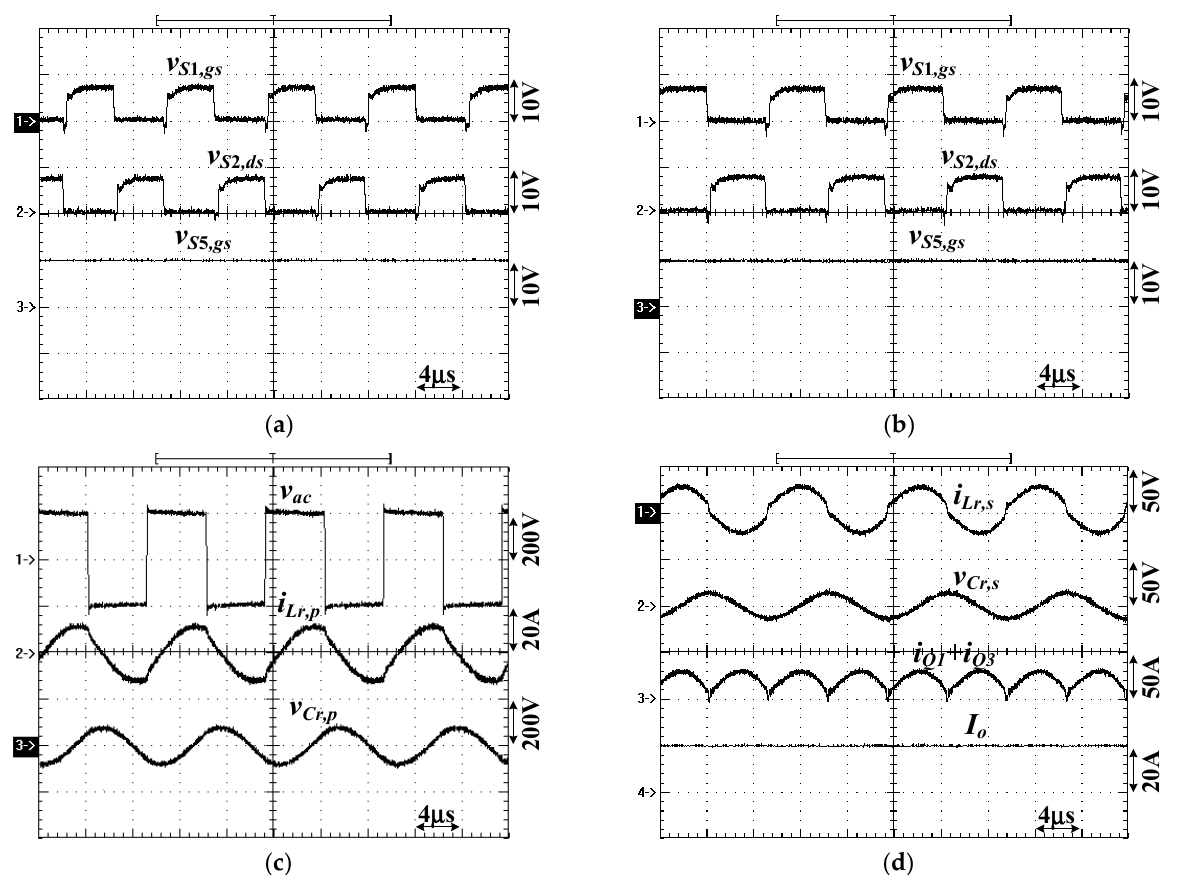
Figure 14. Measured waveforms of the proposed converter operated at forward power flow and V in = 400 V: ( a ) S 1 , S 2 and S 5 signals at 20% load power, ( b ) S 1 , S 2 and S 5 signals at 100% load power, ( c ) v ac , i Lr,p and v Cr,p at full rated power, ( d ) i Lr,s , v Cr,s , i Q 1 + i Q 3 and I o at full rated power.